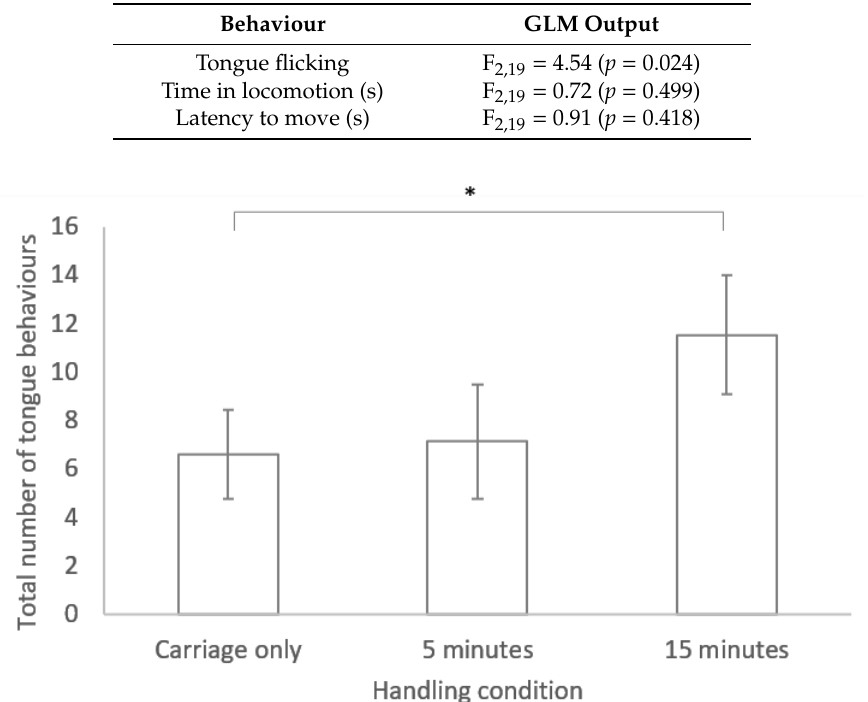
Figure 1. Bar chart of mean ± standard error for the number of tongue behaviours performed during the novel environment test for lizards in the three different handling conditions. * indicates a significant difference ( p < 0.05).